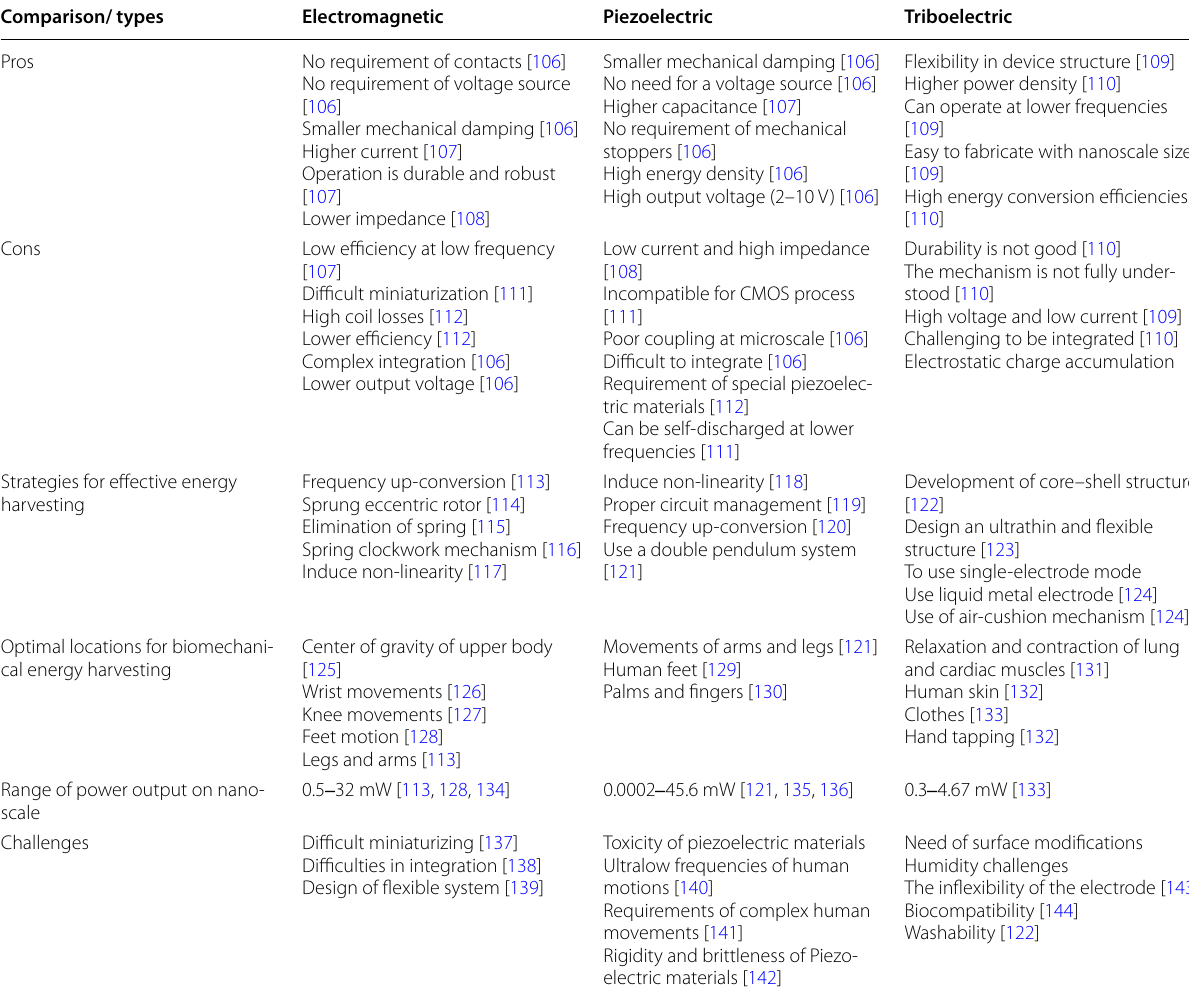
Table 7 Comparison of nanomechanical energy harvesting methods in terms of pros and cons, performance, techniques for efficient utilization, and